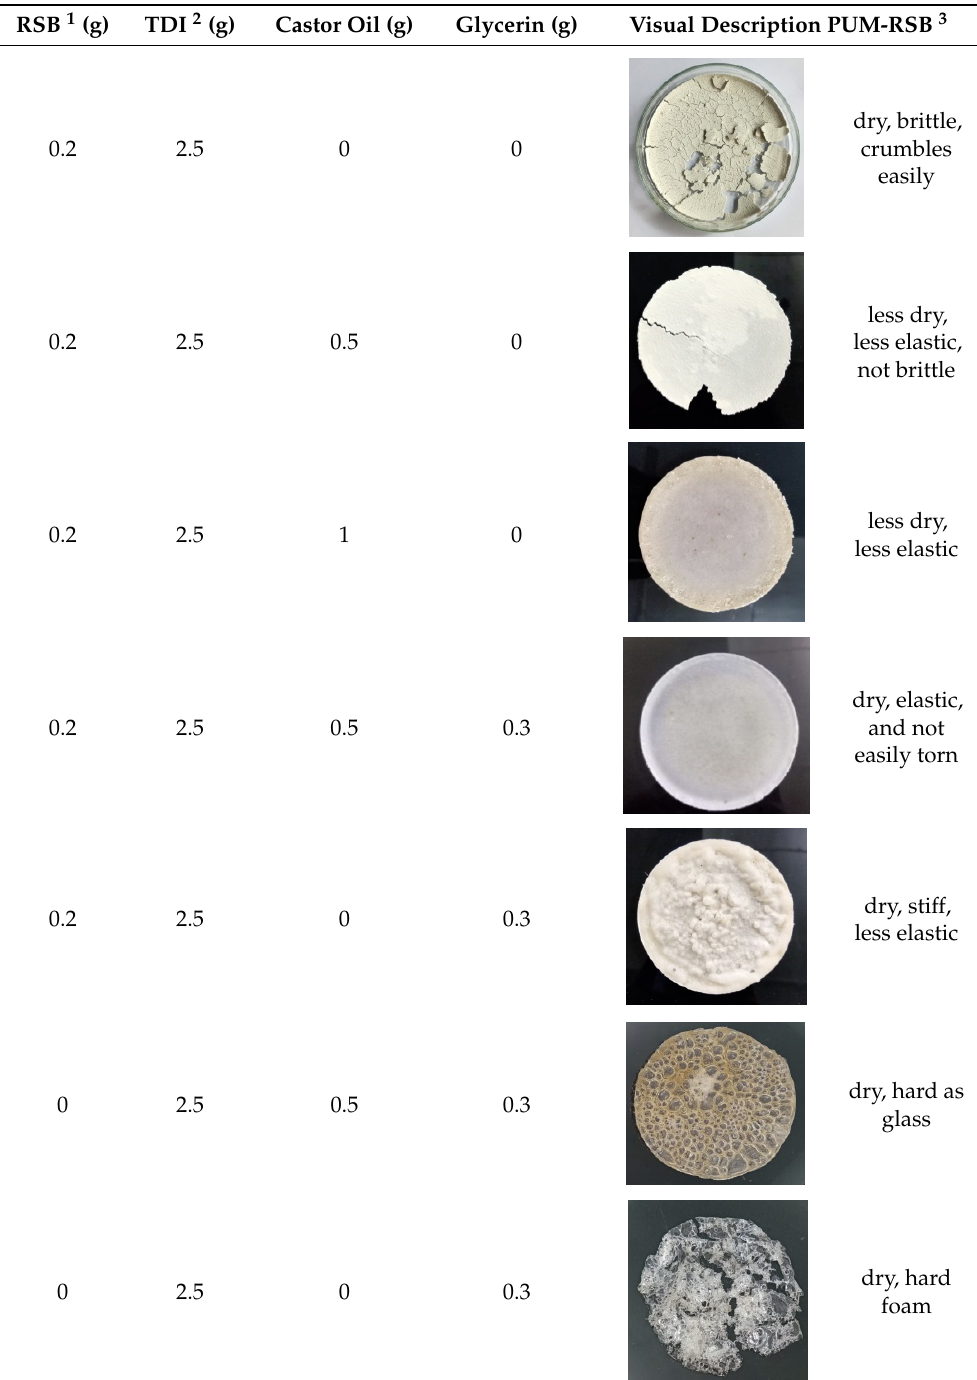
Table 1 . Variations in PUM synthesis using red seaweed biomass .